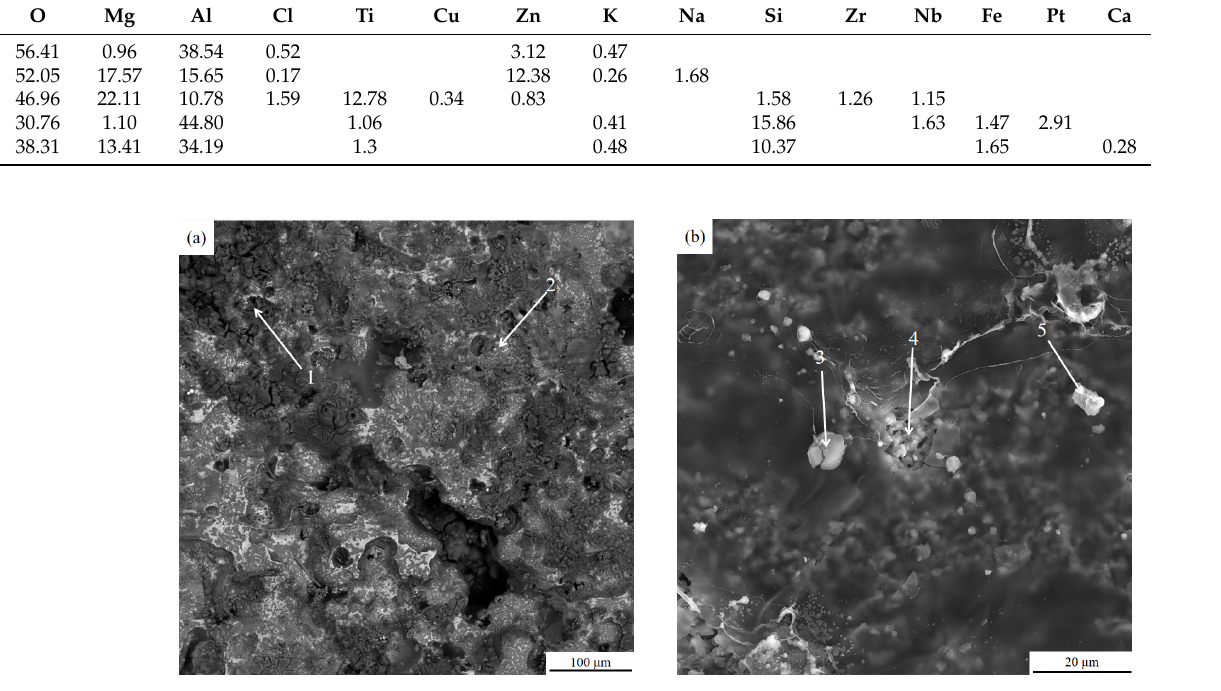
Figure 11. Surface ( a ) and inner surface of cavity channel ( b ) micromorphology of residual aluminum melt sample in ceramic cavity. Table 3. Surface composition of the residual aluminum melt sample in the ceramic cavity and the inner surface of the cavity channel(wt%).